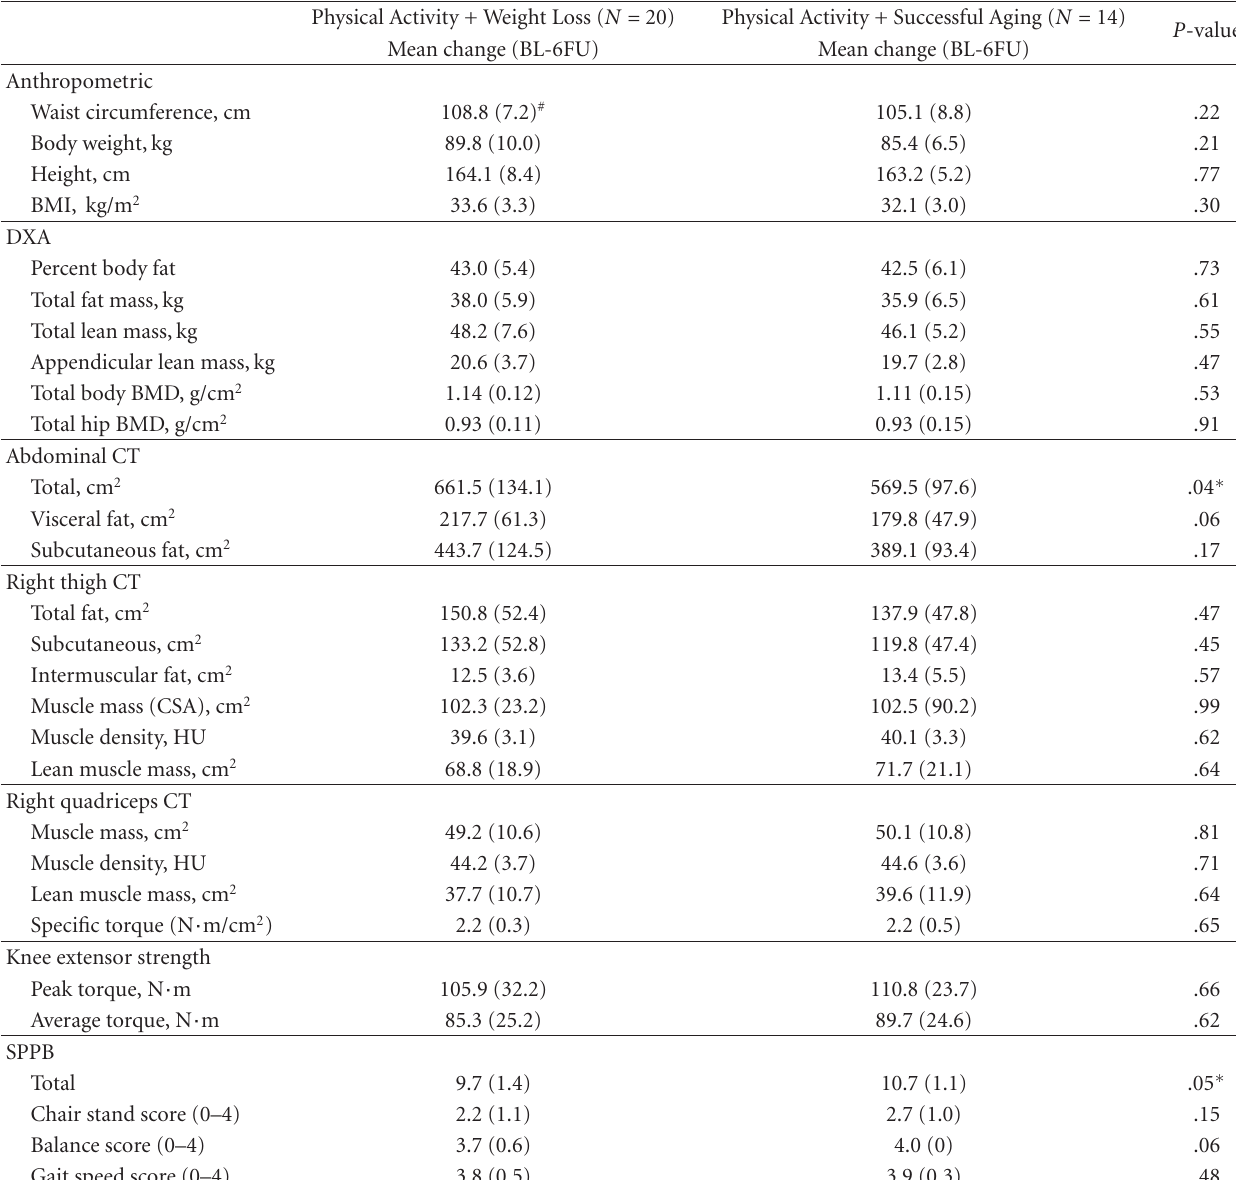
Table 2: Baseline anthropometric, body composition, bone mass, muscle strength, and physical function by intervention